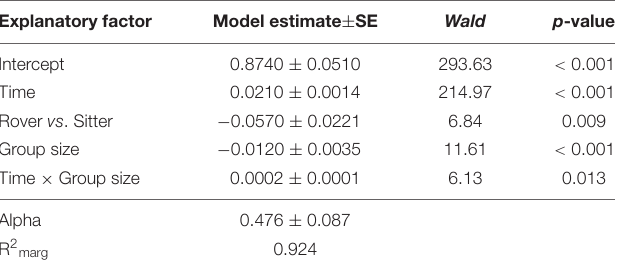
TABLE 3 | Factors influencing expansion of Aspergillus nidulans in Experiment 3. Results of the most parsimonious GEE model (after backward elimination of non-significant factors) are shown.